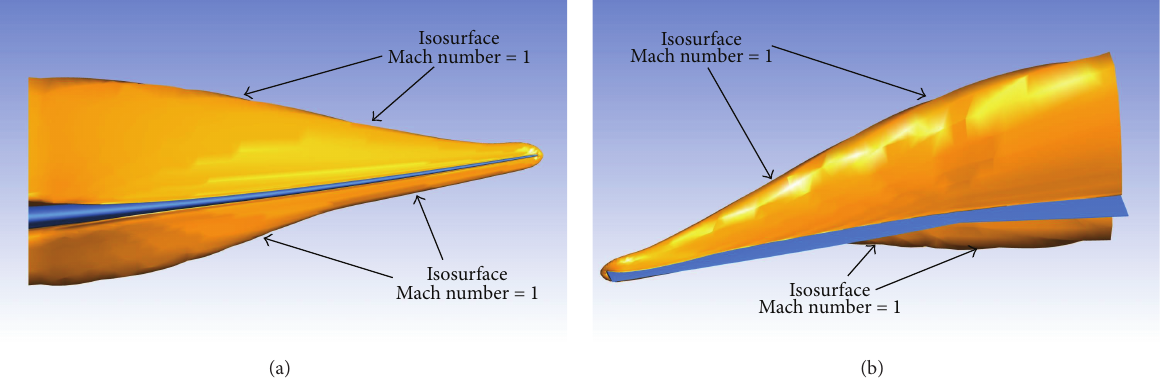
Figure 12: (a) Front view of the supersonic zone around the swept wing (Case 2 , Mach = 0.875, time = 7 s). (b) Rear view of the supersonic zone around the swept wing (Case 2 , Mach = 0.875, time = 7